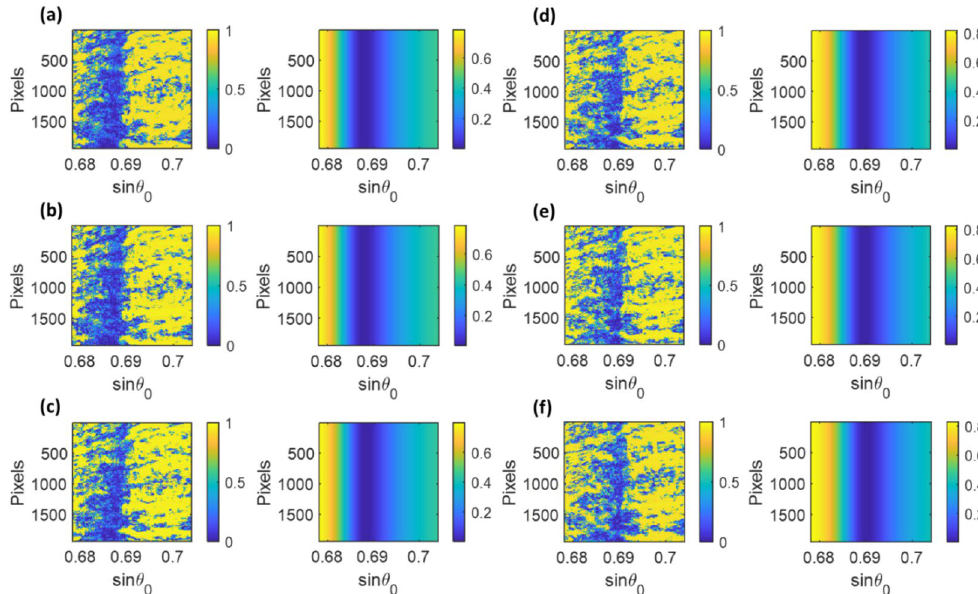
Figure 7. Experimental camera frames (left) and simulated reflectance spectra (right) showing the plasmonic dip positions for 6 different pressures: ( a ) air case, ( b ) 5 psi, ( c ) 40 psi, ( d ) 110 psi, ( e ) 130 psi, and ( f ) 150